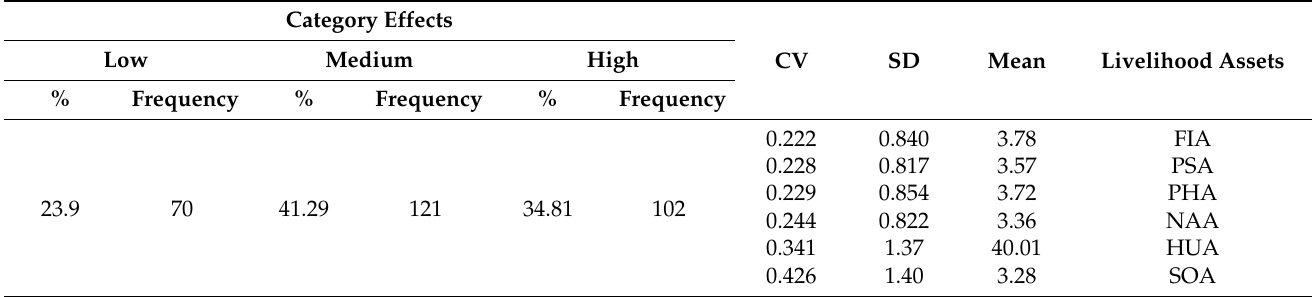
Table 4. The impacts of COVID-19 on livelihood assets.